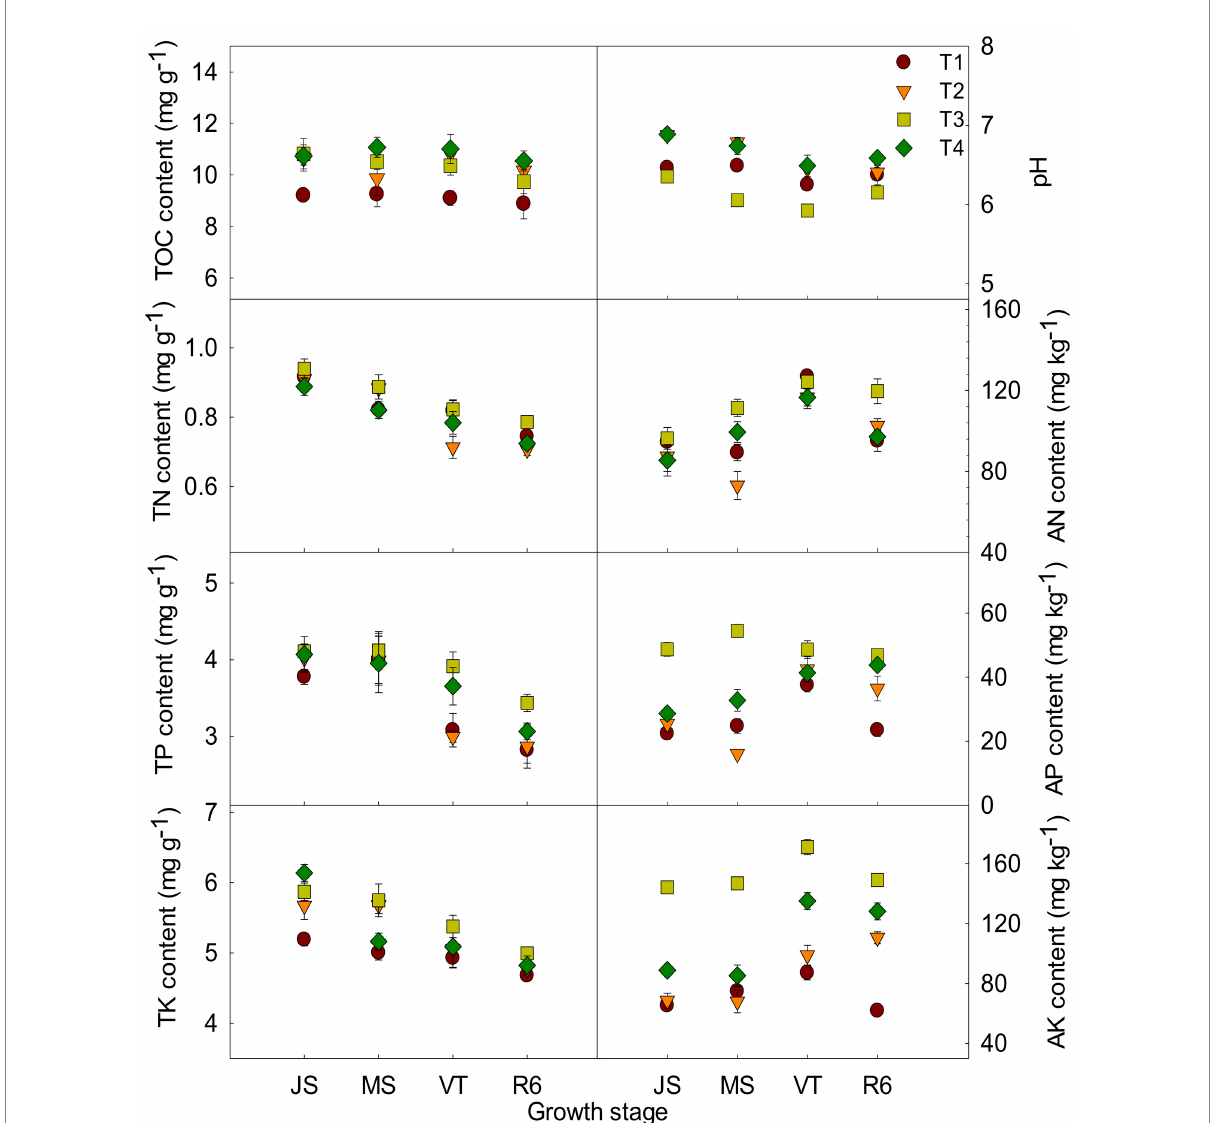
FIGURE 1 Effects of integrated soil-crop management on soil characteristics of summer maize-winter wheat. JS, Jointing stage of wheat; MS, maturity stage of wheat; VT, tasseling stage of maize; R6, maturity stage of maize; TOC, soil total organic carbon; TN, total nitrogen; AN, alkali-hydrolyzed nitrogen; TP, total phosphorus, AP, available phosphorus, TK, total potassium, AK, available